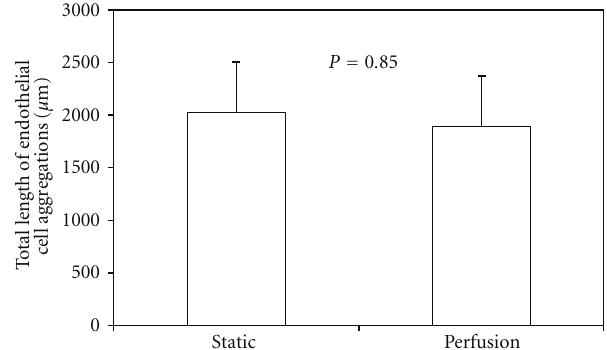
Figure 11: Total length of endothelial cell aggregations does not change with perfusion